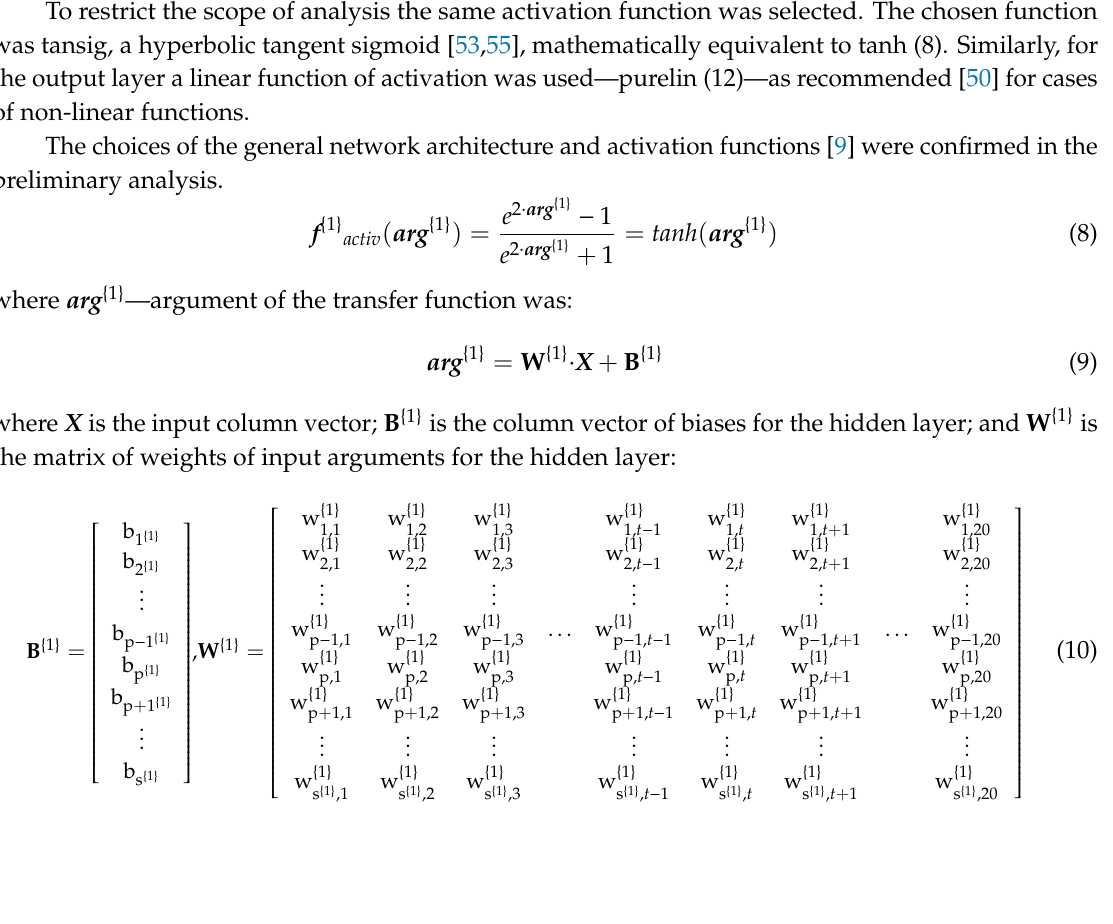
Figure 3. The structure of one approch of neural network used in the study. All symbols are explained in the text.